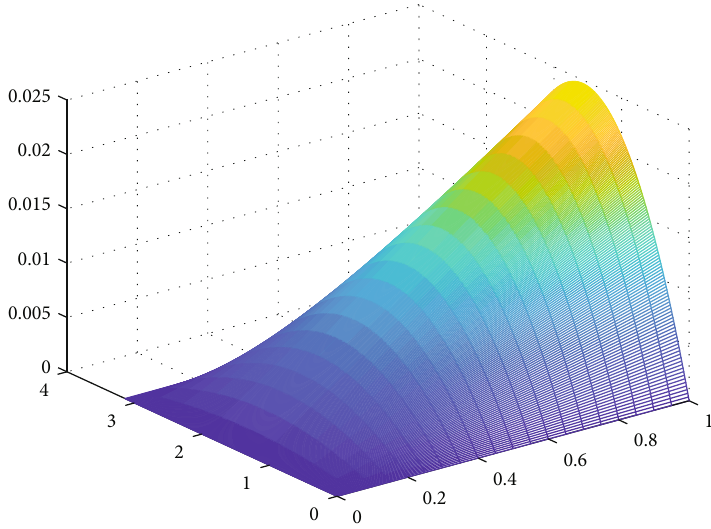
Figure 6: Solution of Test 4 when α = 0 : 8